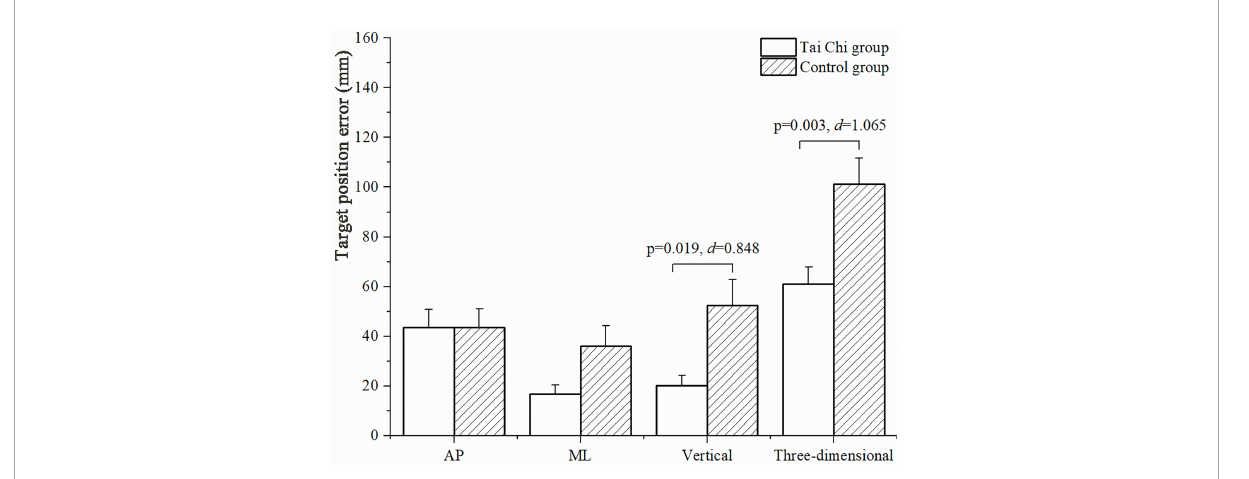
FIGURE2 Target positioning error (TPE) between the finger marker and the removed bar marker in the AP, ML, vertical directions, and in three-dimensional space during the blind touch task (BTT). AP, anterior-posterior; ML,